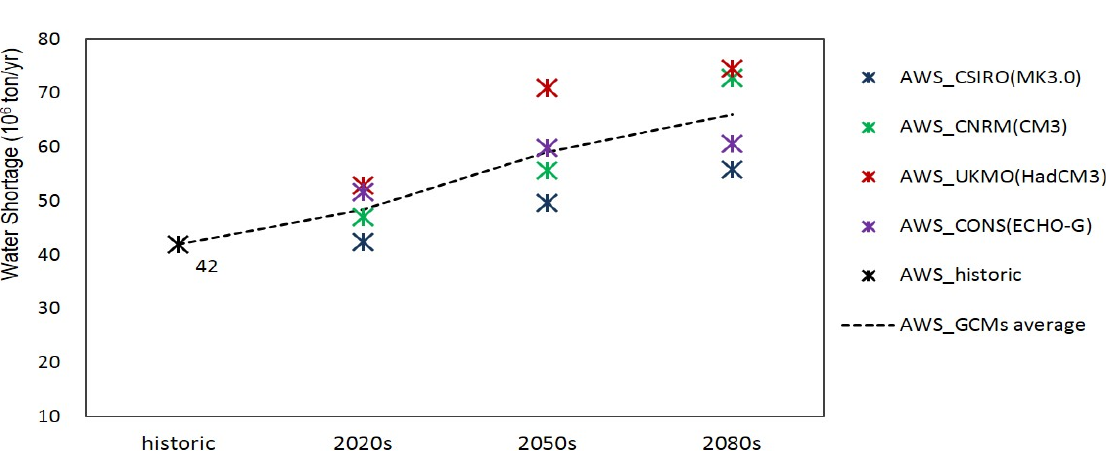
Figure 7. Trend of water shortage projections in the Han River basin: 2020s (2010–2039), 2050s (2040–2069), and 2080s